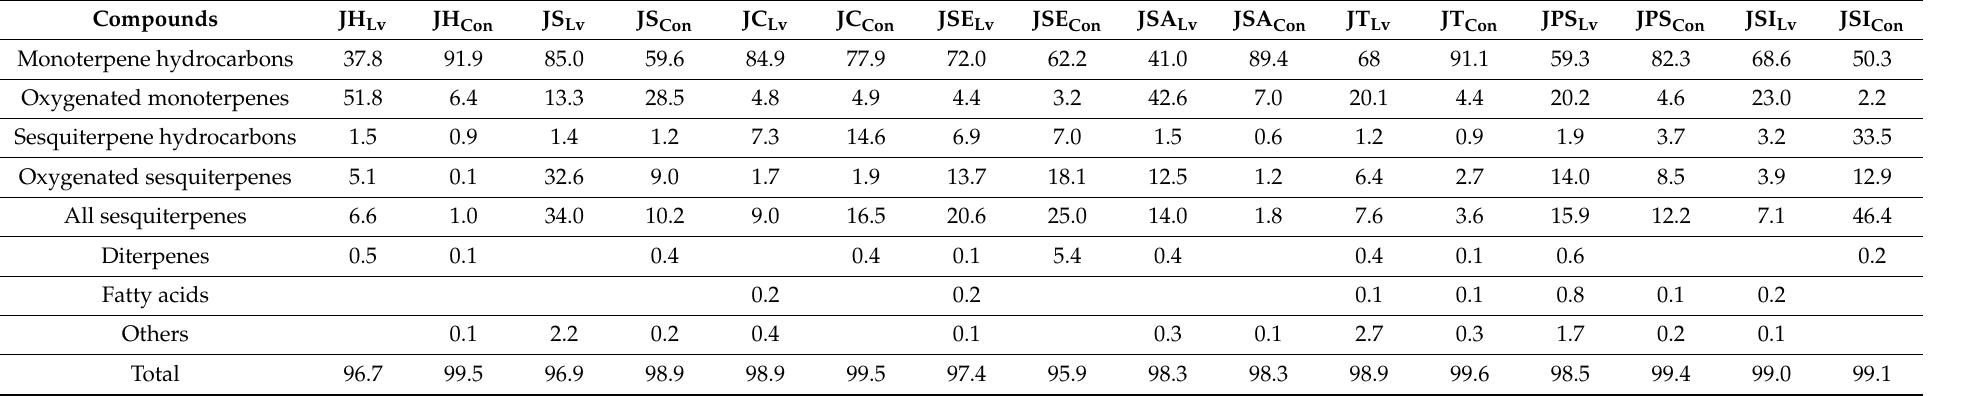
Table 3. Summary of the chemical composition (%) of essential oils from Juniperus